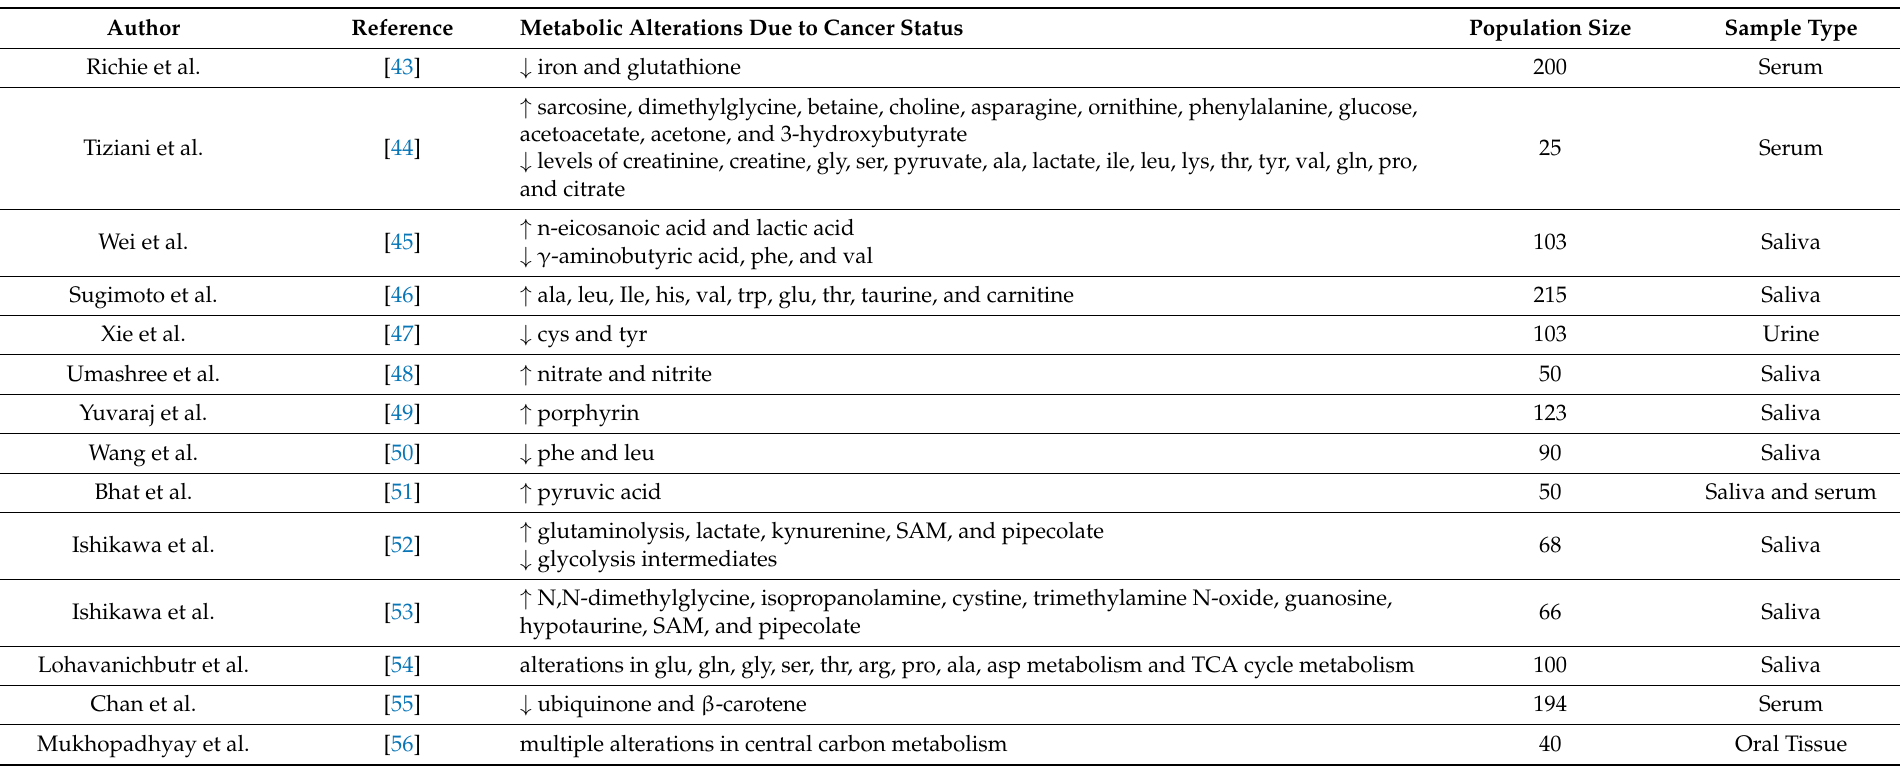
Table 2. Literature review summary of the metabolic features of oral